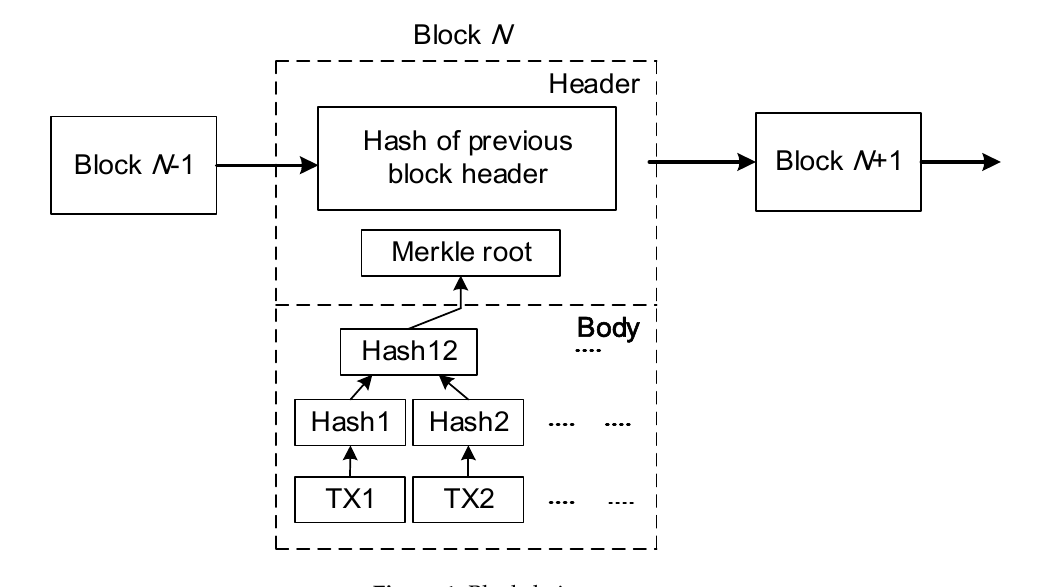
Figure 1. Blockchain structure.